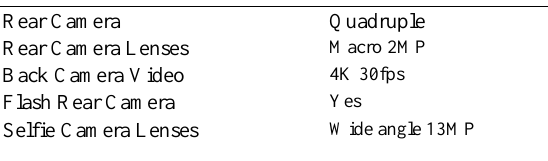
Table 1: Characteristics of